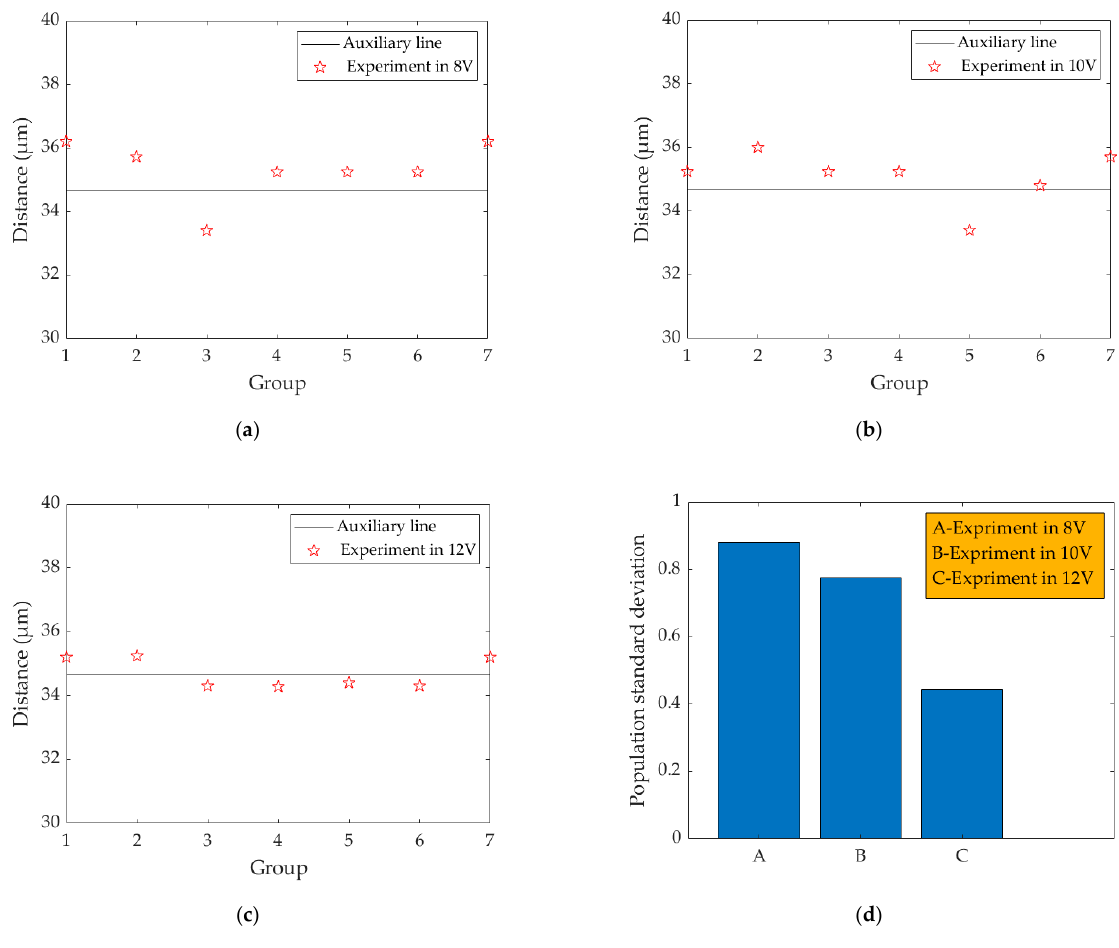
Figure 15. The distance between two adjacent centers at different voltages: ( a ) at 8 V; ( b ) at 10 V; ( c ) at 12 V. ( d ) The population standard deviation of the distance between adjacent droplets under the different driving voltages.